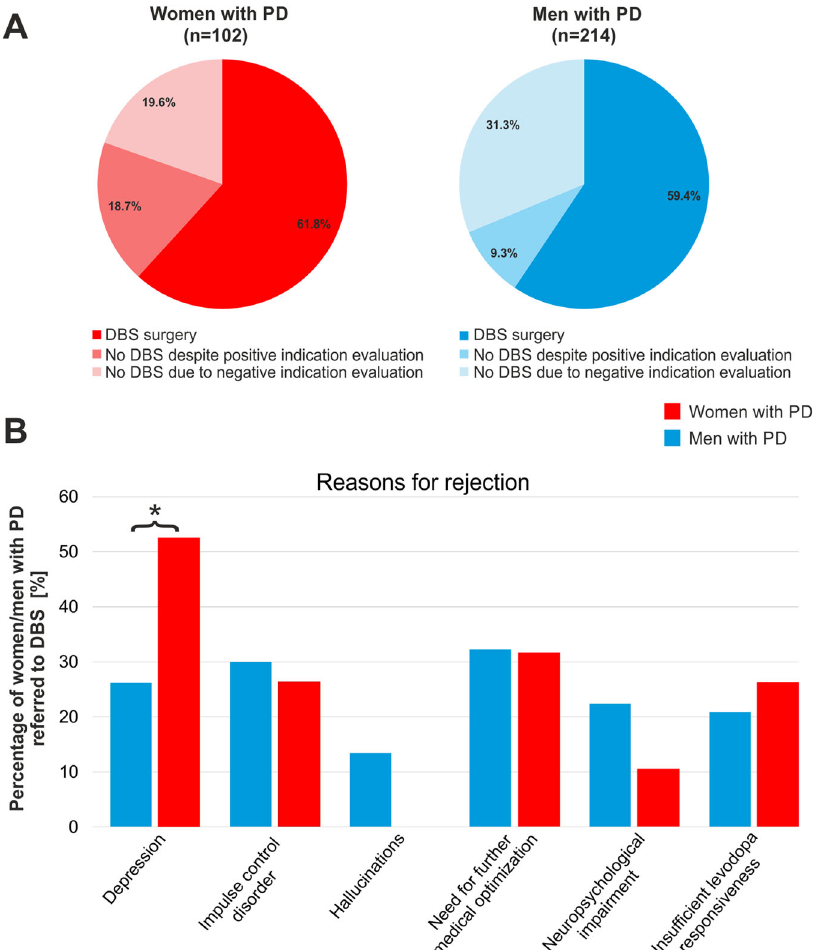
Fig. 1 Gender ratio and reasons for not receiving deep brain stimulation in the cross-sectional cohort. In ( A ), pie charts illustrate ratios of women (left) and men (right) with Parkinson ’ s disease who underwent DBS surgery, or did not undergo DBS surgery either despite positive indication evaluation or due to negative indication evaluation. In ( B ), bar charts illustrate the percentage of women and men with PD rejected for different reasons in DBS indication evaluations. 53 patients had one reason for rejection, 29 patients had at least two reasons for rejection, 5 patients had other reasons for rejection (mania, pre-existing orthopedic or cardiovascular conditions). The black star represents signi fi cantly more rejections due to depression in women than in men with PD. DBS Deep brain stimulation, PD Parkinson ’ s Supplementary Tables 1 and 2. In summary, differences in effect